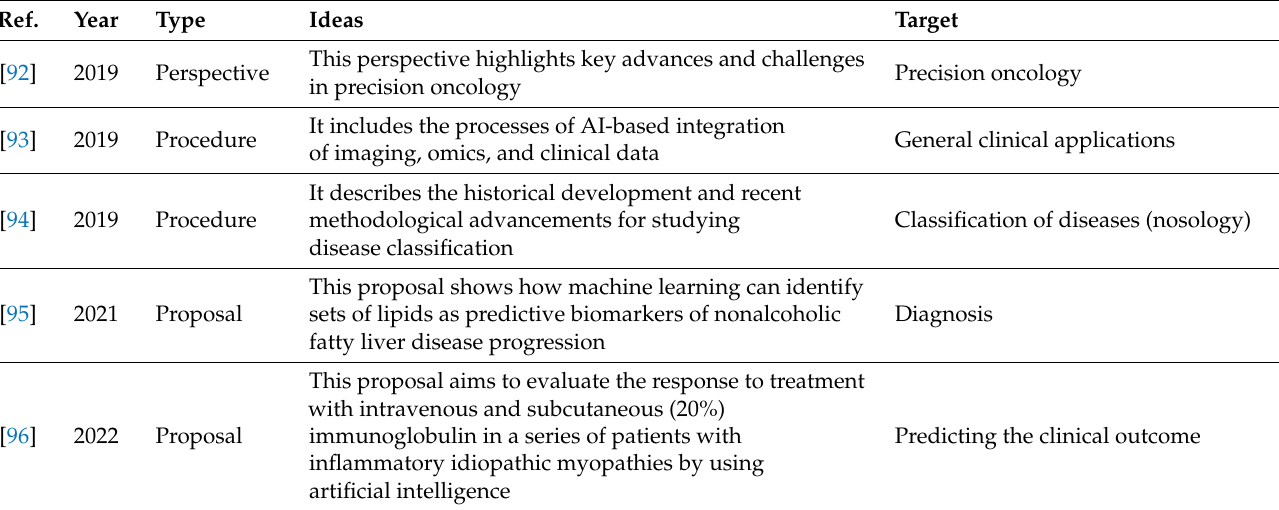
Table 5. Guideline articles.